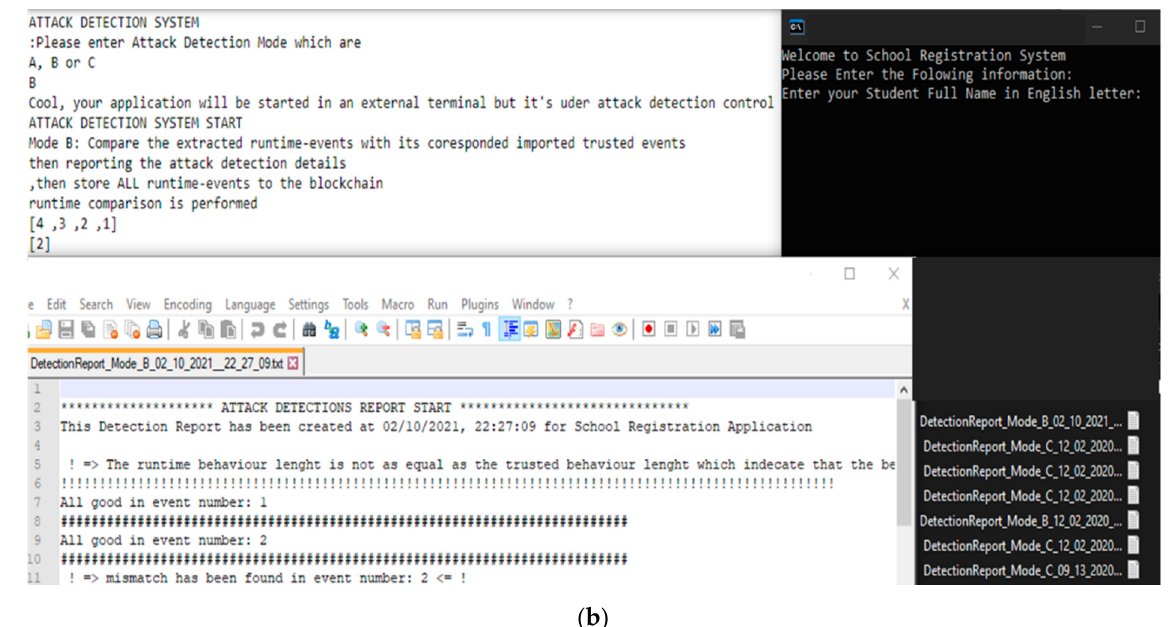
Figure 8. Screenshots from some tools used in the experiment for ( a ) ADP Subsystem; ( b ) RAD Subsystem.